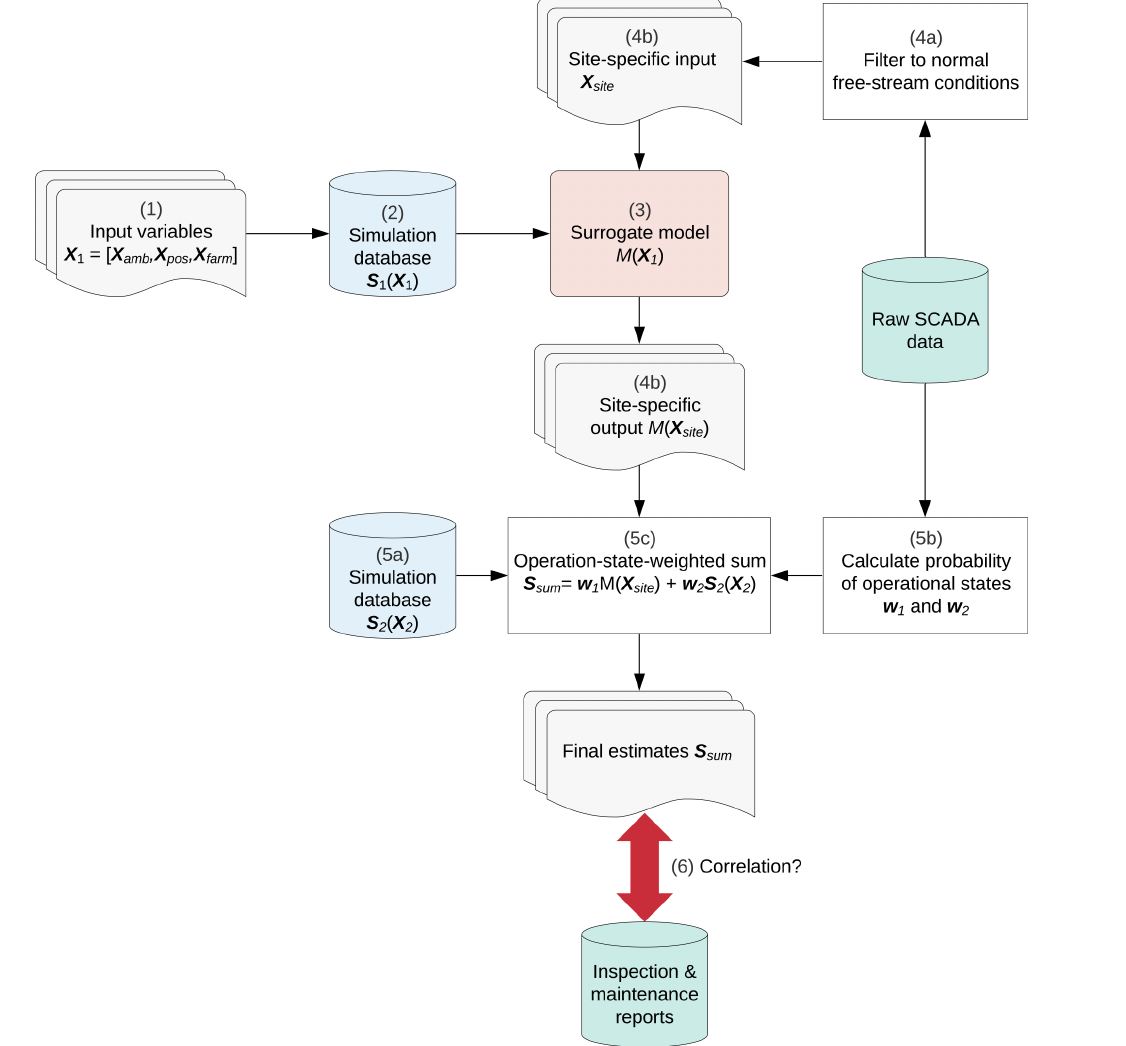
Figure 1. Methodology for estimating performance, loading condition and lifetime characteristics within a wind